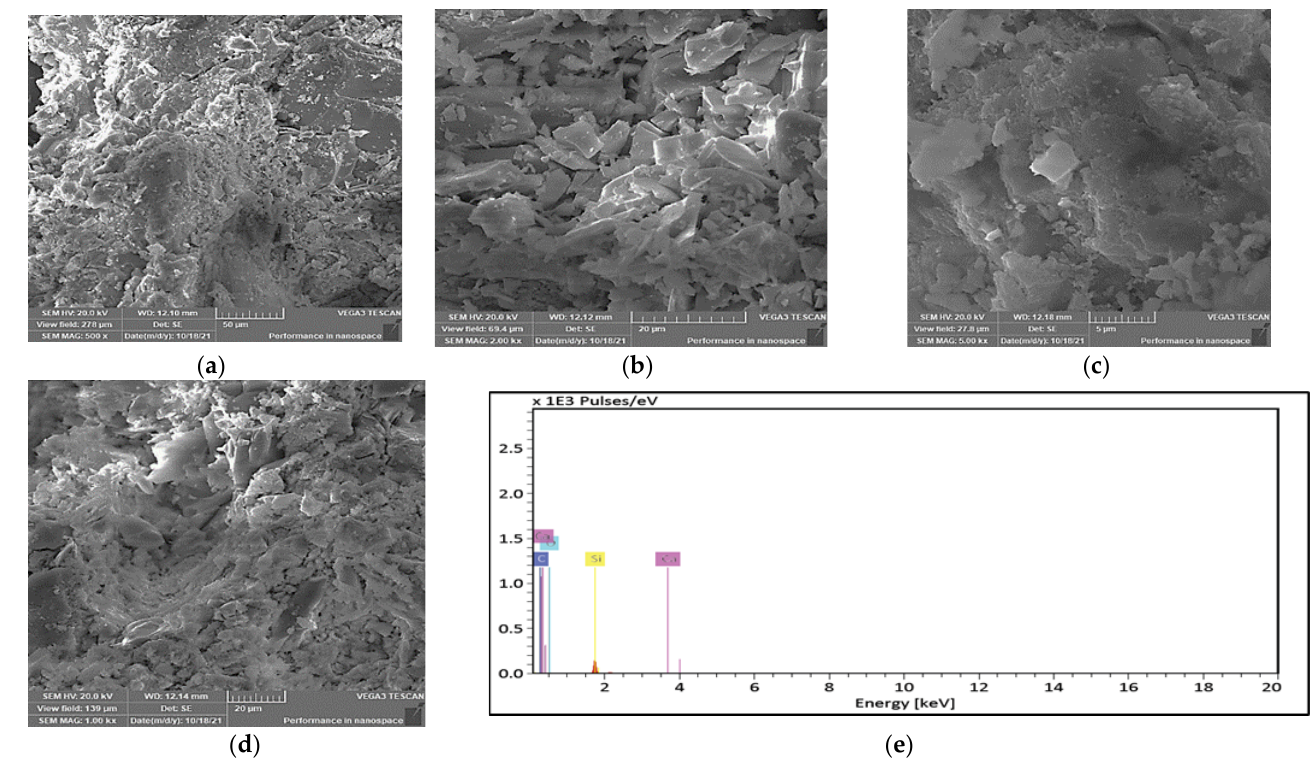
Figure 14. SEM with various magnification factors ( a – d ); ( e ) EDX for the mix UHPC 3 at normal curing temperatures.